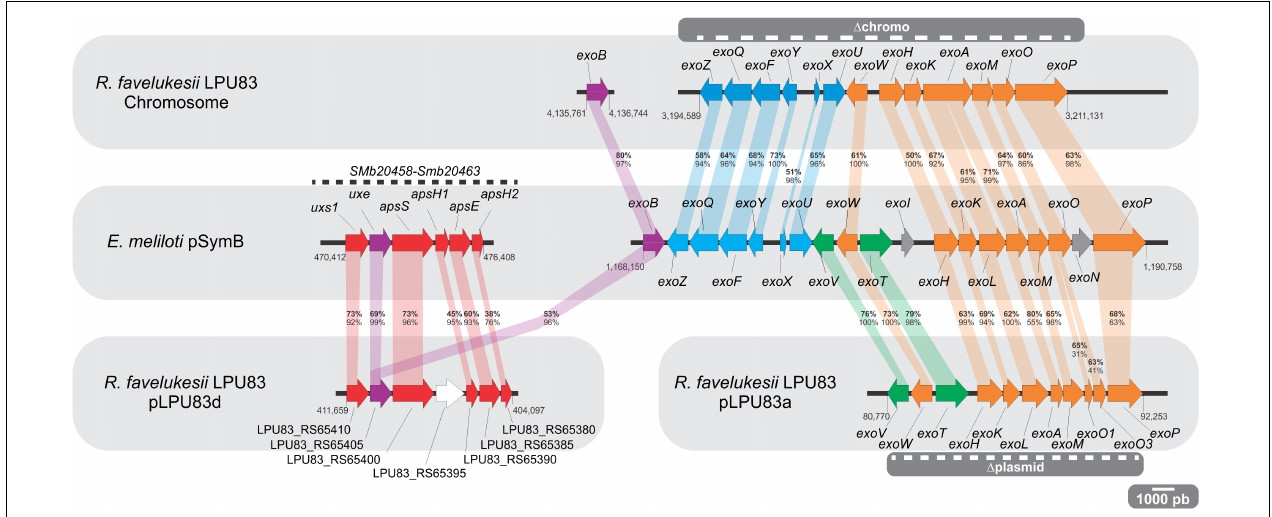
FIGURE 1 | Genetic organization of the EPS I and APS genes. The E. meliloti pSymB figure (middle) shows the organization of the cluster of genes involved in APS (left) and EPS I (right) synthesis. The upper box shows the distribution of orthologs to EPS I production genes, distributed among R. favelukesii LPU83 chromosome. The bottom box shows the distribution of orthologs to APS (left) and EPS I (right) production genes, distributed among plasmids pLPU83d and pLPU83a, respectively. Numbers at the beginning and at the end of each cluster indicate the position of each gene. Orthologs are marked and connected with similar colors. Percentages in bold stand for amino acidic identity of the proteins. Percentages below bold-numbers stand for query coverage. All the comparisons were made using E. meliloti 2011 exo genes as query. The striped lines within gray boxes indicate the deletions made in the exo cluster of the chromosome and the plasmid.